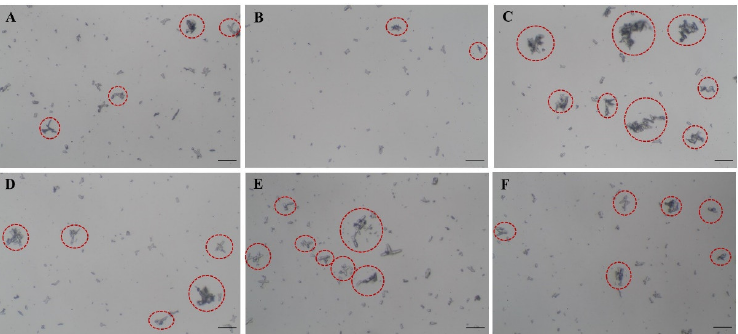
Figure 2. COM crystal aggregation morphology under microaerobic of the blank control ( A ), negative control ( B ), positive control ( C ), E. coli ( D ), P. mirabilis ( E ), and co-cultured E. coli and P. mirabilis ( F ). Original magnification and scale bar ( ) were 100× and 50 µm, respectively.